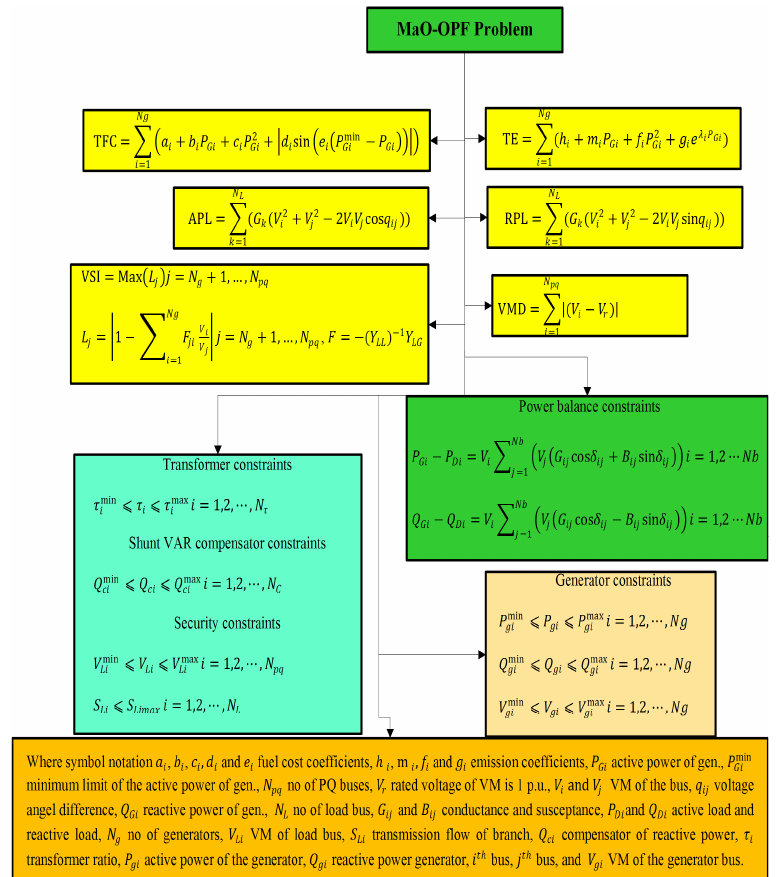
Fig. 1. Flowchart of OPF problem with objective function and